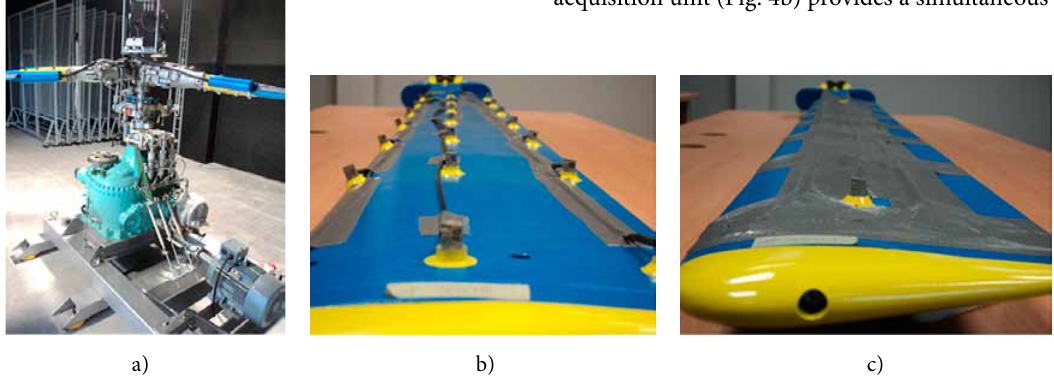
Fig. 3. The test bench for the experimental system and the blade